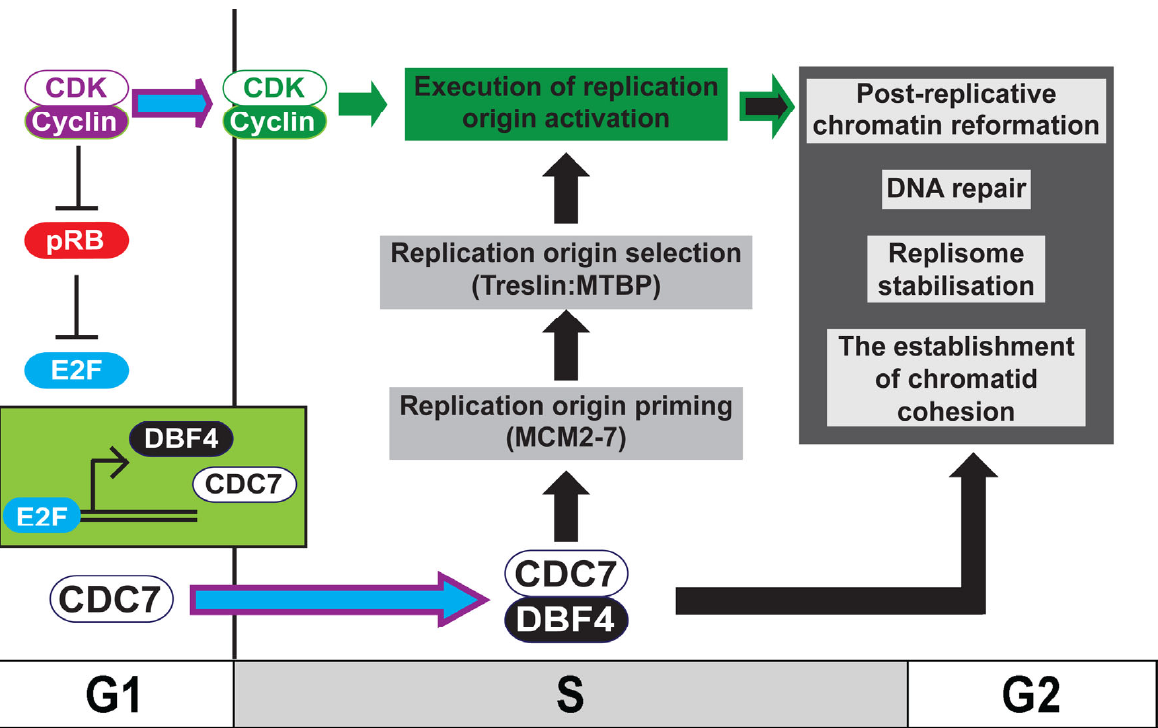
Figure 1. Model for the role of DDK in ensuring chromosome stability. Activation of Cdc7 and Dbf4 transcription by E2F in higher eukaryotes occurs following the inactivation of pRB by rising CDK levels at the G1 ‐ to ‐ S transition. During S phase, the activation of replication origins requires the